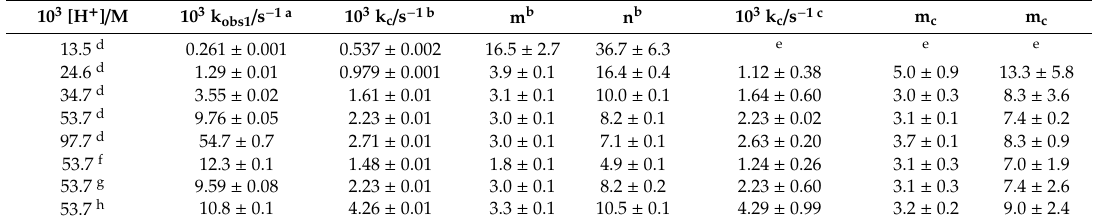
Table 1. Relevant kinetic parameters for the demetallation of ZnTPPS 4 ( k obs1 ) and aggregation of H 2 TPPS 4 in J-aggregates ( k c , m and n ) as function of [H + ] and ionic strength (T = 298 K). 10 3 [H + ] /